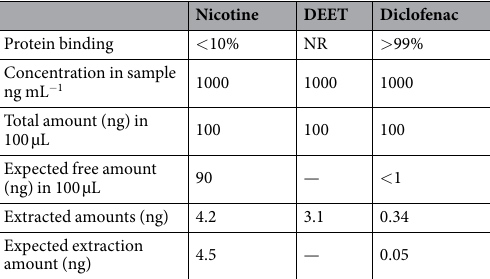
Table 1. Extraction amounts from calf serum with developed TF-SPME method. Expected extraction amounts were calculated based on 5% depletion from the free concentration. Protein binding of DEET has not been reported (NR) in the literature. Extraction conditions: analyte concentration of 1000 ng mL − 1 , extraction time 30 sec, 30 min equilibration between extractions, desorption time 10